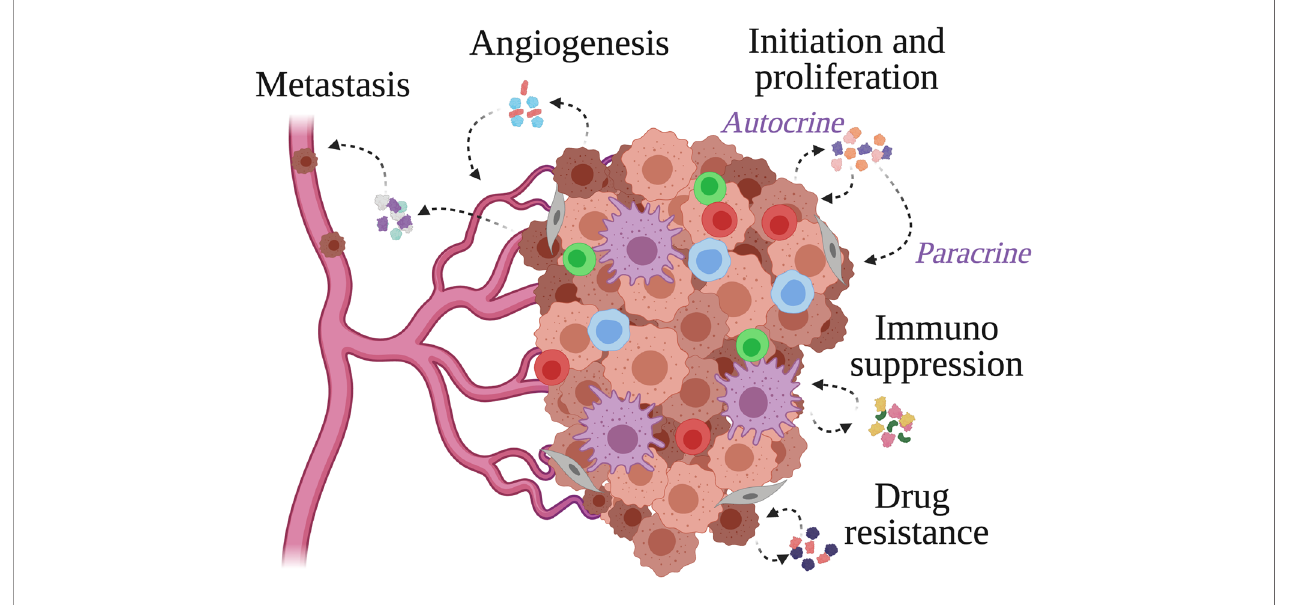
FIGURE 1 | Cytokine actions within the tumor microenvironment. Cancer cells, stromal cells and immune cells populate the tumor microenvironment and secrete cytokines to facilitate the events supporting tumor growth. These include tumor cell initiation and proliferation, immunosuppression, angiogenesis, metastasis, and resistance to anti-cancer